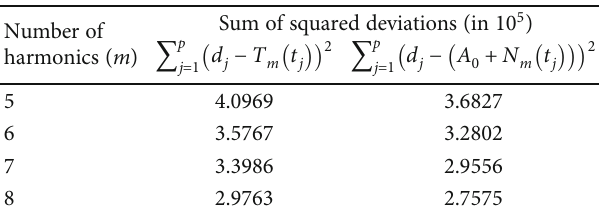
t Þ and A + N t Þ . m ð 0 m ð